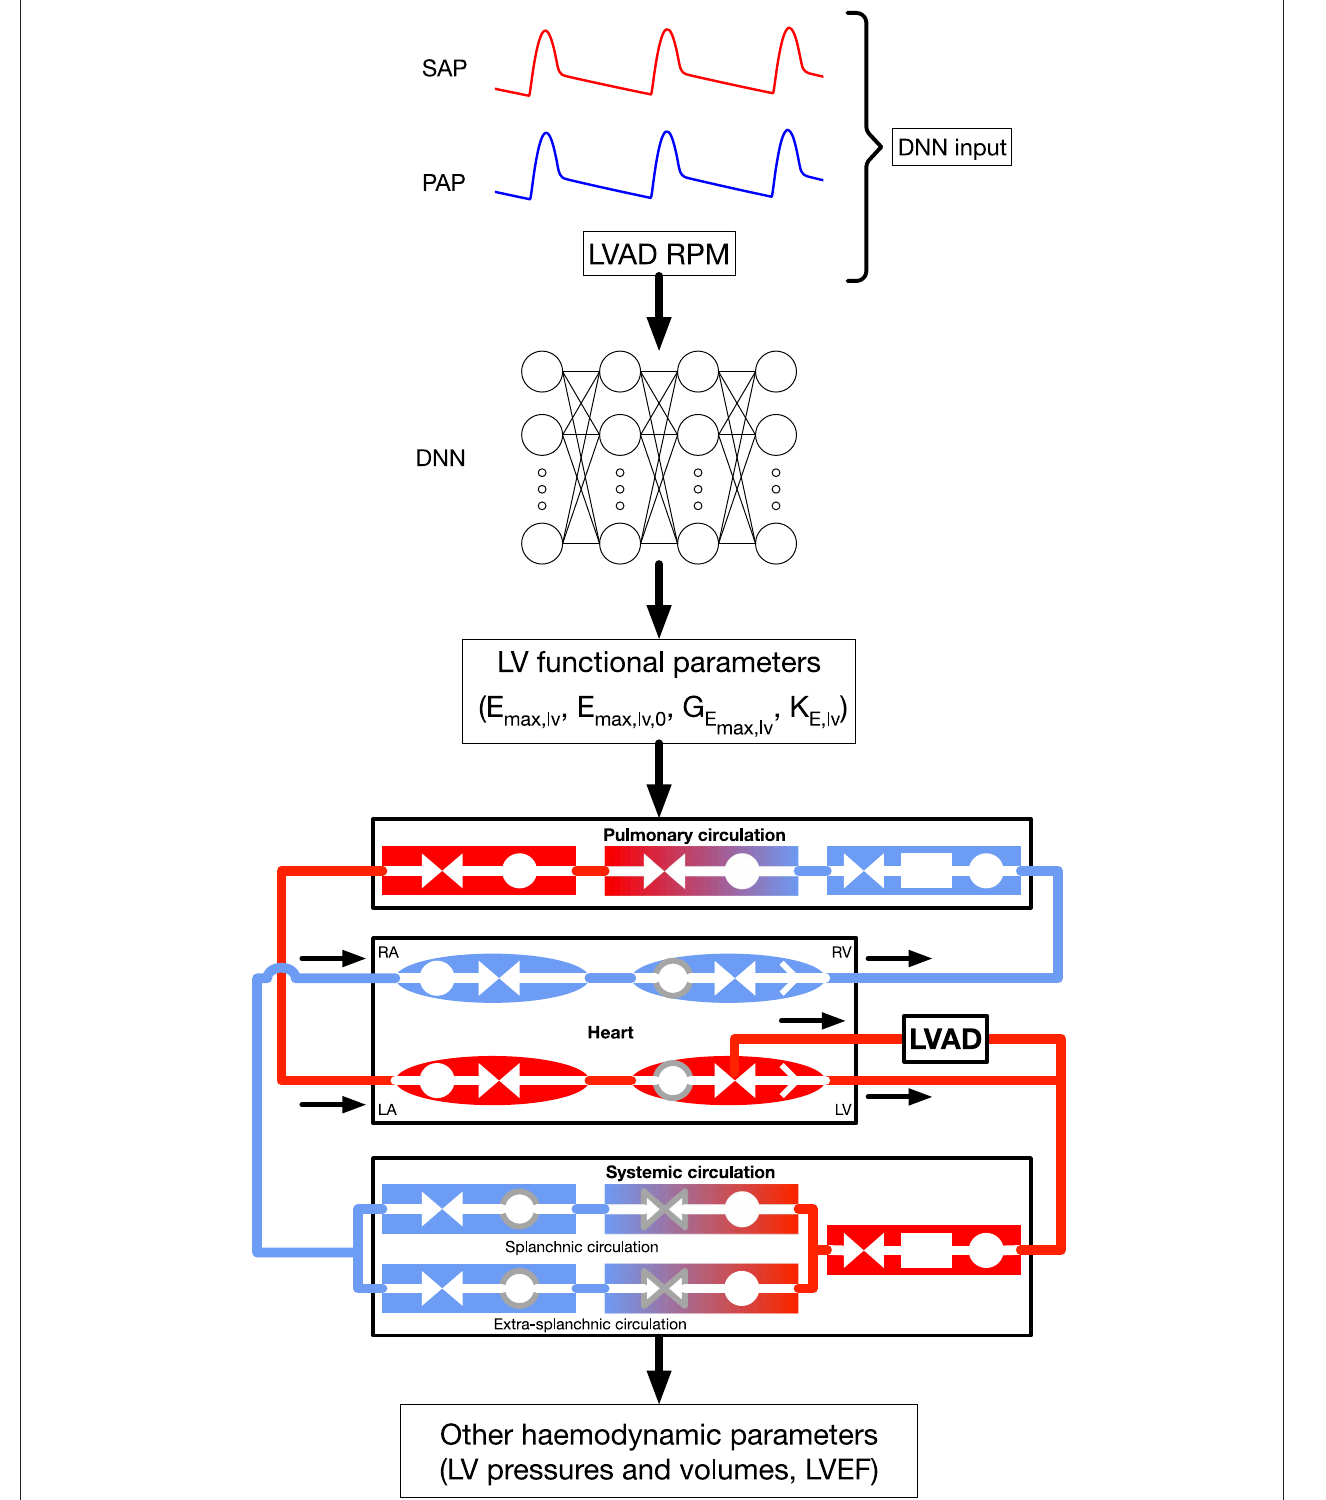
FIGURE 1 | General framework, modified from Bonnemain et al. (12) under CC-BY license. The DNN is fed with systemic and pulmonary arterial pressures, formulated in their frequency domain, as well as LVAD RPM, to predict parameters of LV systolic function. These parameters are integrated to the 0D model to